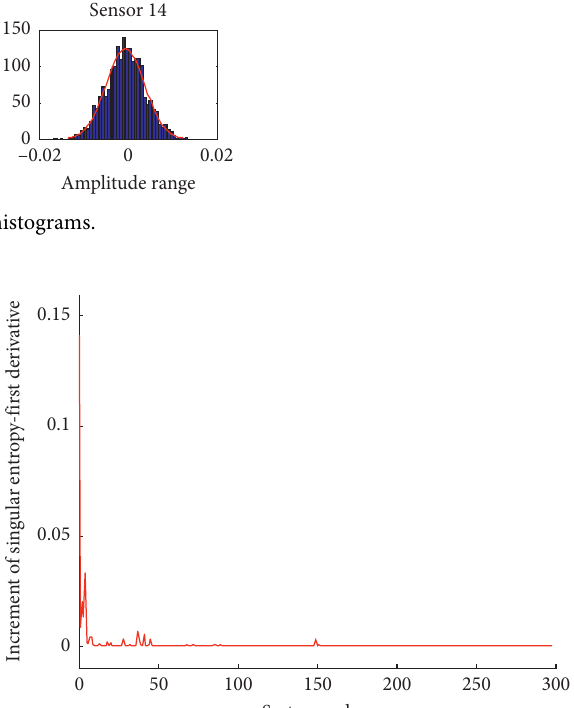
Figure 13: Data histograms.